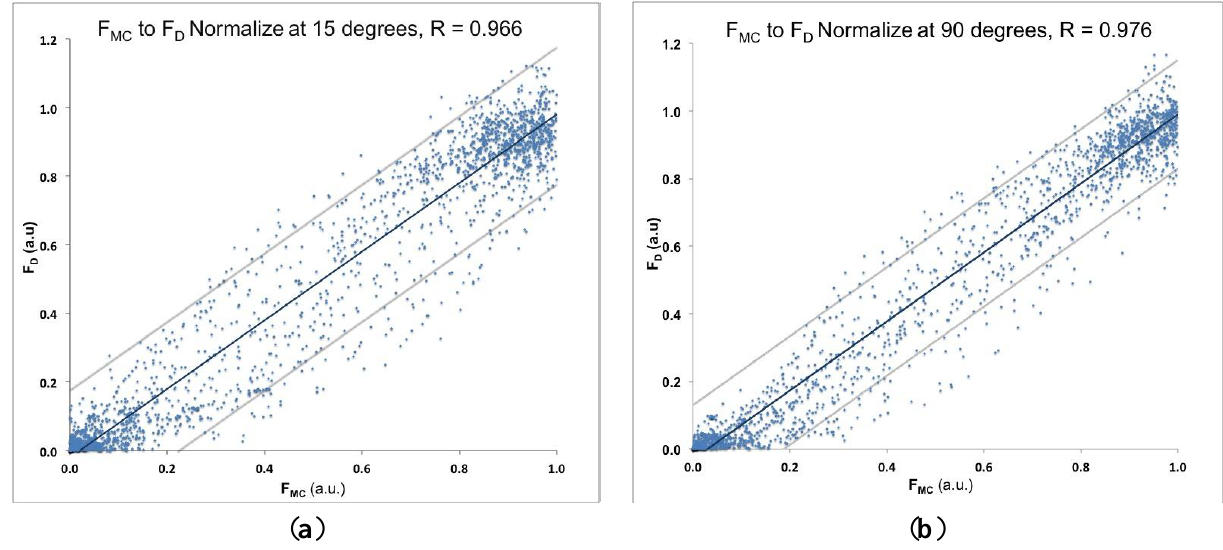
Figure 5. ( a ) Scatter plot of normalized F regression line and confidence bands at 0.95. Correlation coefficient was R = 0.966; ( b ) Scatter plot of normalized F and confidence bands at 0.95. Correlation coefficient was R =